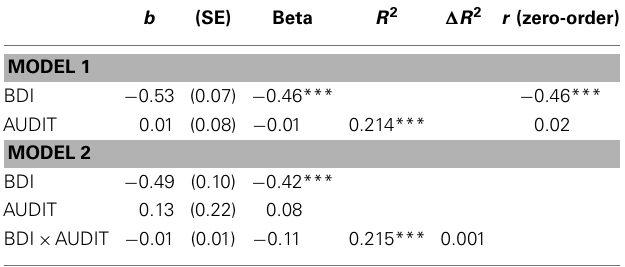
Table 1 | Hierarchical regression